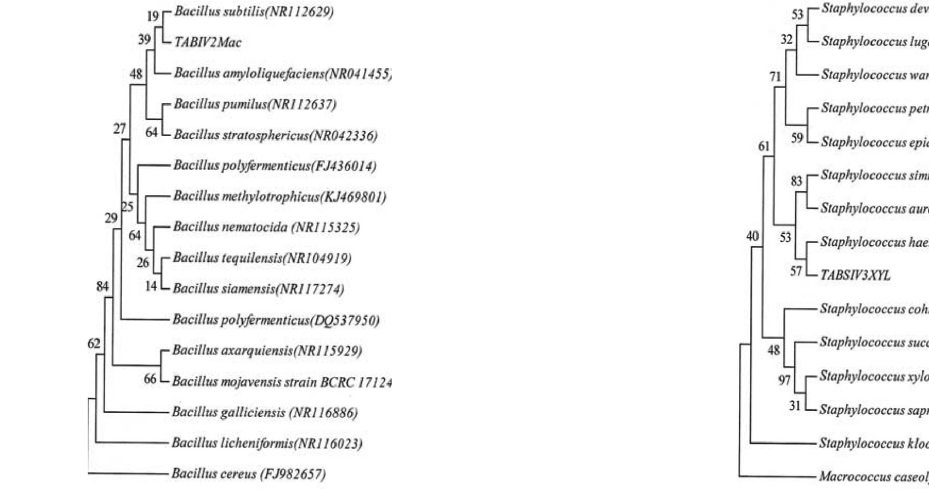
FIGURE 8 - Neighbor-joining tree based on 16S rRNA (1590) sequences showing the relationship between unknown isolate TABSIV3XYL and other closely related species of the genus